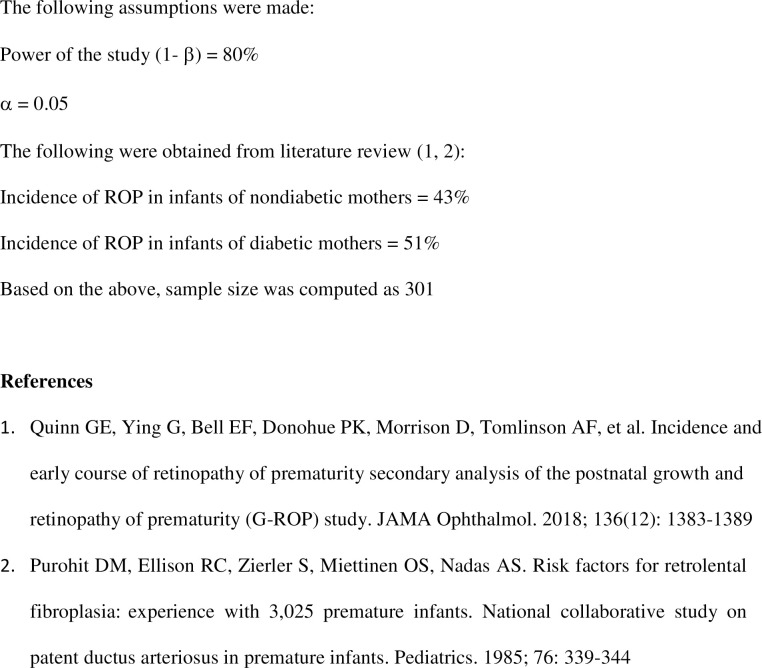
Sample size calculation.